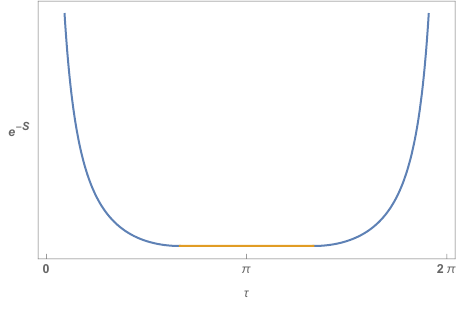
Figure 4 . Correlator in 2d (we strip off numerical factors). In blue/yellow we depict the region where the U-shape/straight configuration